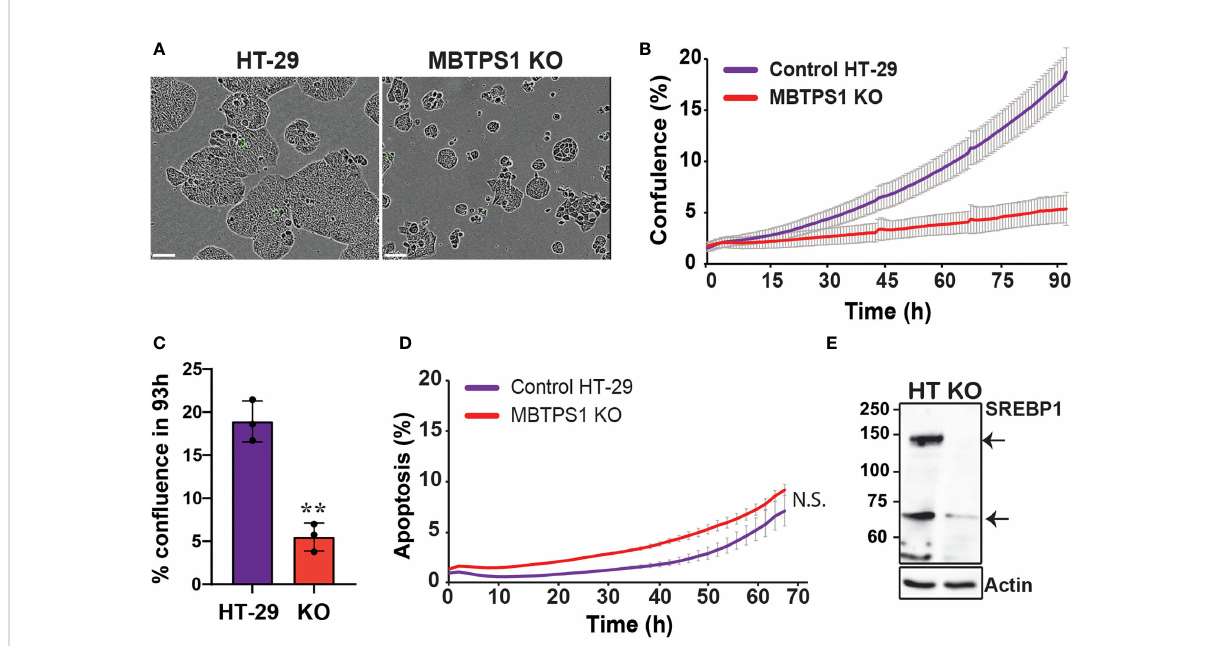
FIGURE 4 CRISPR/Cas9-mediated knockout of the MBTPS1 gene attenuates cell proliferation of colon cancer-derived HT-29 cells. (A) Representative images of original HT-29 and MBTPS1 KO cells. Scale bar represents 300 mm. (B) Knockout of MBTPS1 in HT-29 cells leads to attenuated proliferation. Shown is a representative of six independent experiments tracking the growth of original HT-29 and MBTPS1 KO cells, average ± SD of n =3 for each condition. (C) % con fl uence of original HT-29 and MBTPS1 KO cells 96 h after seeding ( n =3, t-test, **P<0.001). (D) Staining of original HT-29 and MBTPS1 KO cells with the active caspase 3/7 reagent did not show signi fi cant differences in the percentage of apoptosis between the two cell lines. Shown is an average ± SD of n =2 for each condition. (E) A representative immunoblot of control HT-29 and MBTPS1 KO cells stained for SREBP1 showing a signi fi cant reduction in the expression of SREBP1 precursor (125 kD, top arrow) and mature SREBP1 (68 kD, bottom